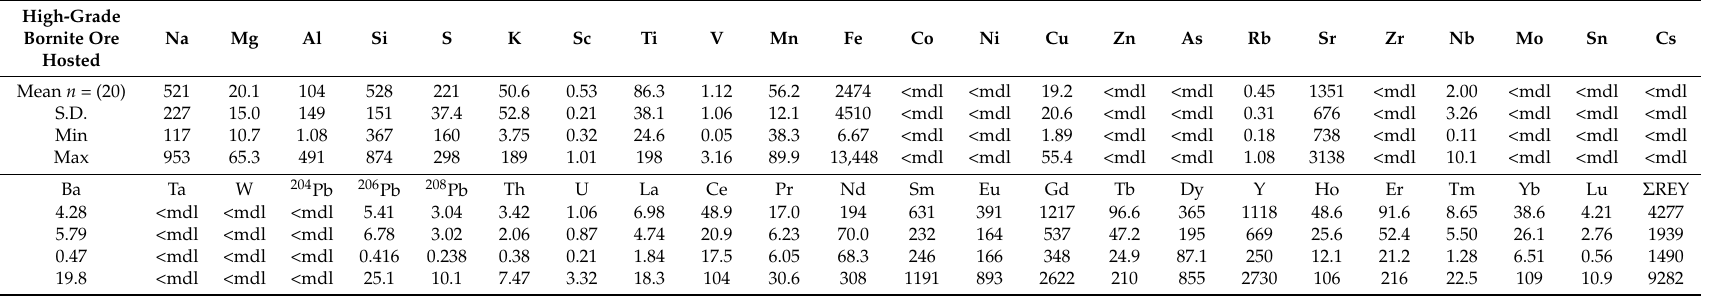
Table 7. REE and trace element concentrations in apatite from high-grade bornite ore (ppm). Apatite analyses were performed on multiple grains in samples: OD10.1, 10.2, 10.3.